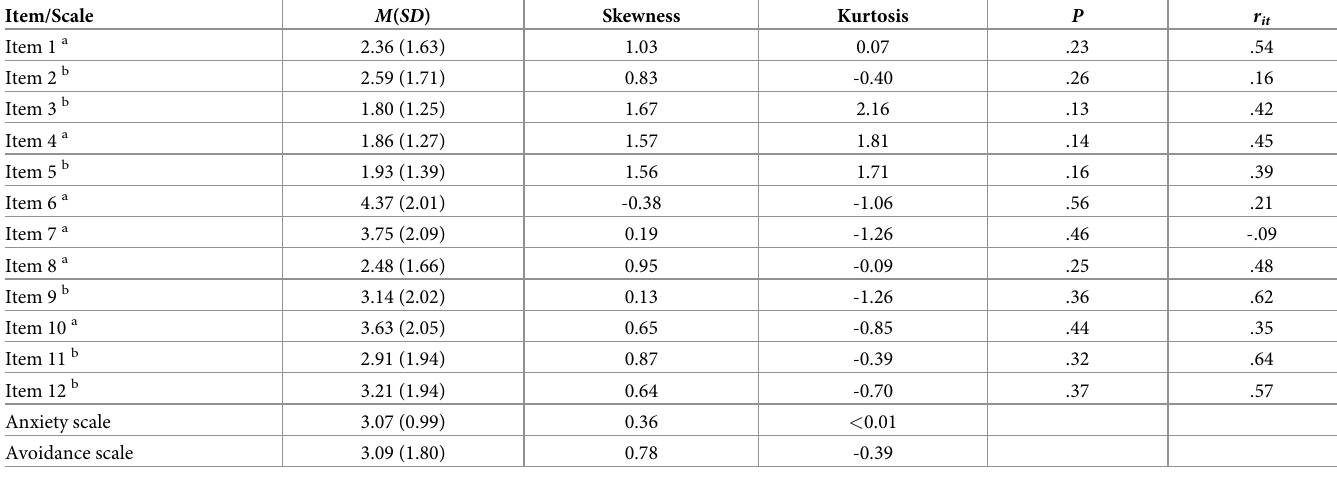
Table 4. Characteristics of the ECR-S12